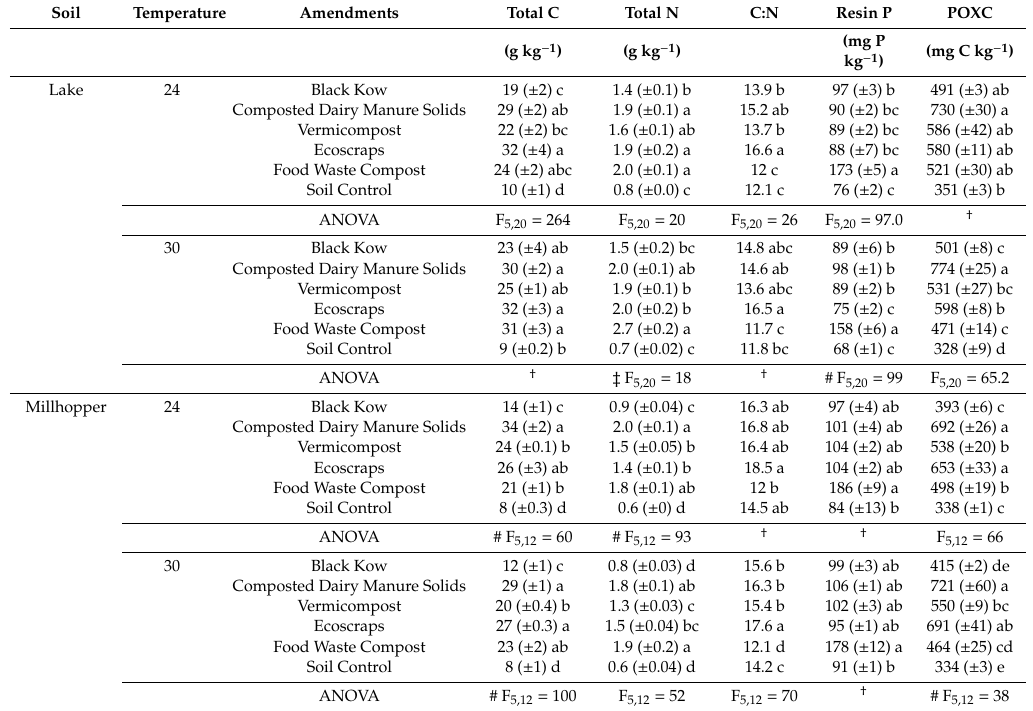
Table 4. Mean ( ± standard error) of multiple measurements (one measurement per jar, two to five total jars per treatment) for total N and C, resin P and permanganate-oxidizable C (POXC) measured at week 8. ANOVA were performed on mean concentrations between treatments. Di ff erent letters amongst amendments within each soil x temperature combination represent significant di ff erences based on Tukey’s HSD ( α = 0.05) or Kruskal–Wallis pairwise comparisons ( p < 0.05) ( † ).